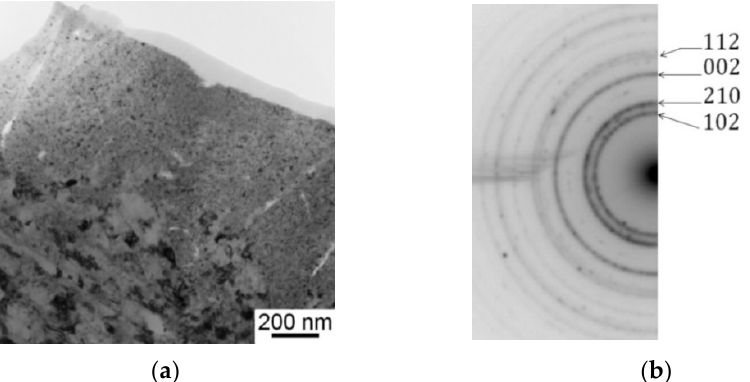
Figure 2. TEM bright-field image ( a ) and associated selected area electron diffraction (SAED) pat- tern ( b ) of the microstructure of the uppermost surface layer of the Ti-6Al-4V sample subjected to UIT. Apart from the oxidation process, the refinement of α -Ti grains and β -Ti interlayers